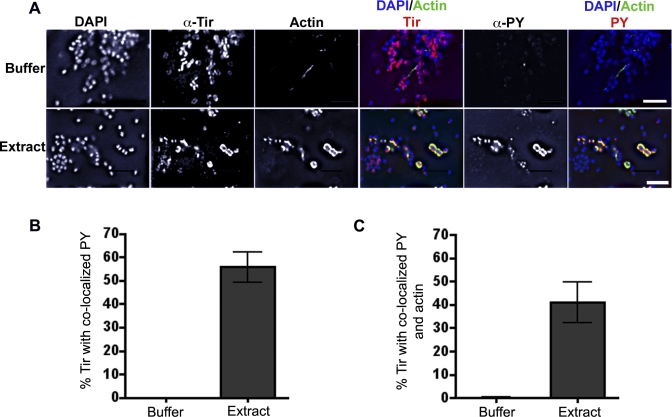
Actin Colocalizes with Tir and Phosphotyrosine (PY) Staining in RBC Infected with EPEC and Exposed to Extract(A) Images of RBC infected with EPEC and exposed to either buffer or extract. Cells are labeled with DAPI to identify EPEC, Alexa-488 phalloidin to visualize actin, and either anti-Tir antibody or anti-PY 4G10 antibody. Note that tyrosine phosphorylation and actin polymerization in extract-treated RBC is colocalized with Tir.(B) Quantitative analysis of colocalization of Tir and PY staining beneath attached EPEC in RBC exposed to either buffer or extract.(C) Quantitative analysis of colocalization of Tir, PY, and actin staining beneath attached EPEC in RBC exposed to either buffer or extract. Scale bars in all images represent 5 μm.